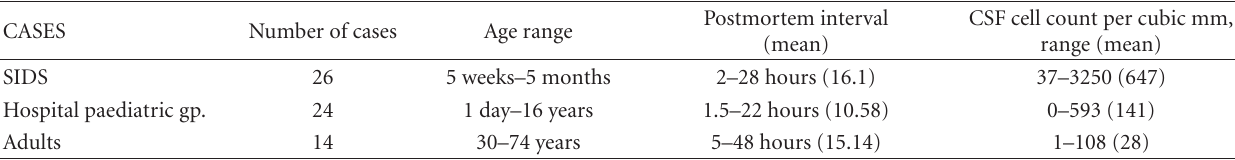
Table 1: Data from Platt et al [2].